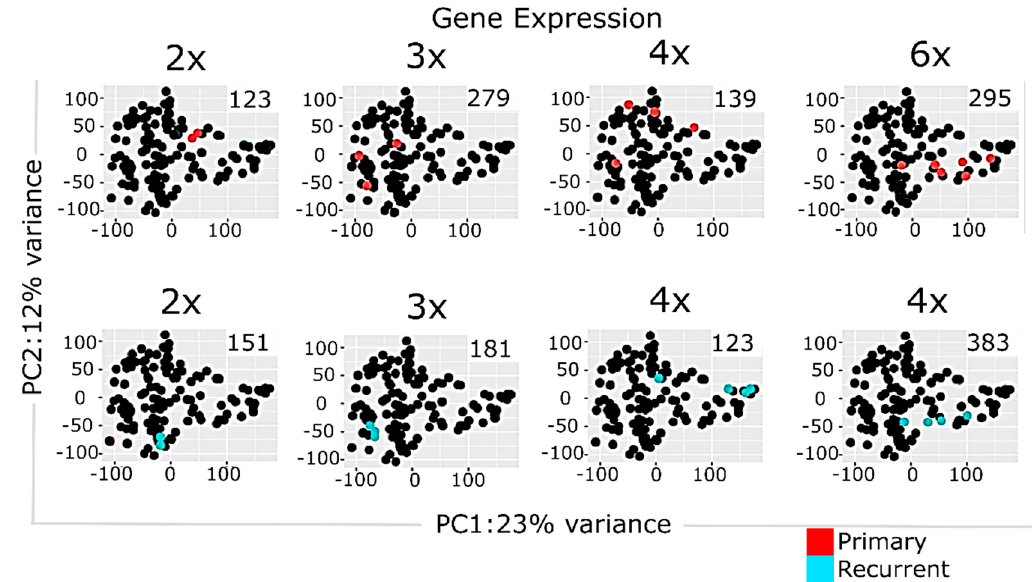
Figure 3. Principal component analysis of multisampled GB tissues using normalized gene expression data. Panels represent, respectively, colored data for individual tumors. Number of profiled samples is indicated. Color marker indicates tissue type (ndGB or recGB). Values aligned with axis show proportion of variance in percent for principal components 1 and 2,